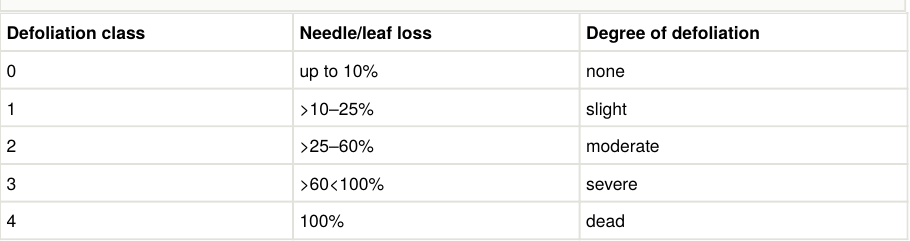
Table 2. Defoliation classes of tree and shrub